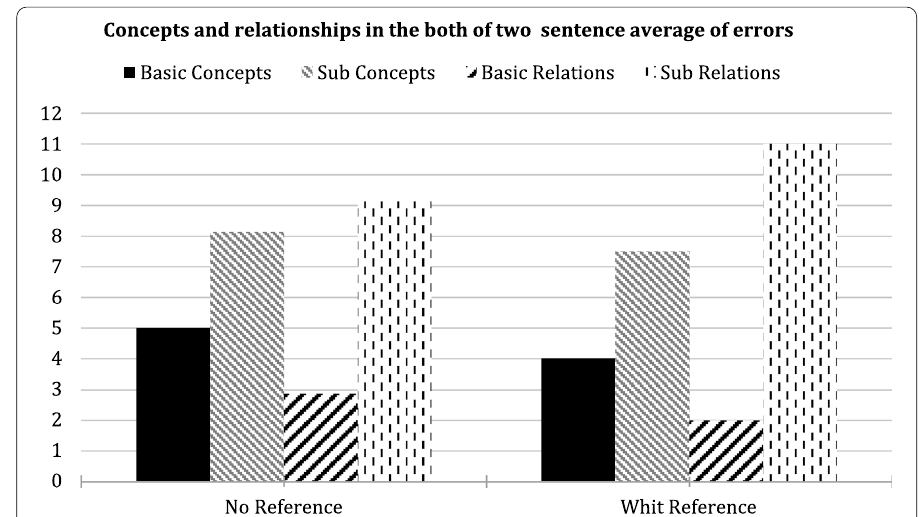
Fig. 8 Average errors in concepts and relationships